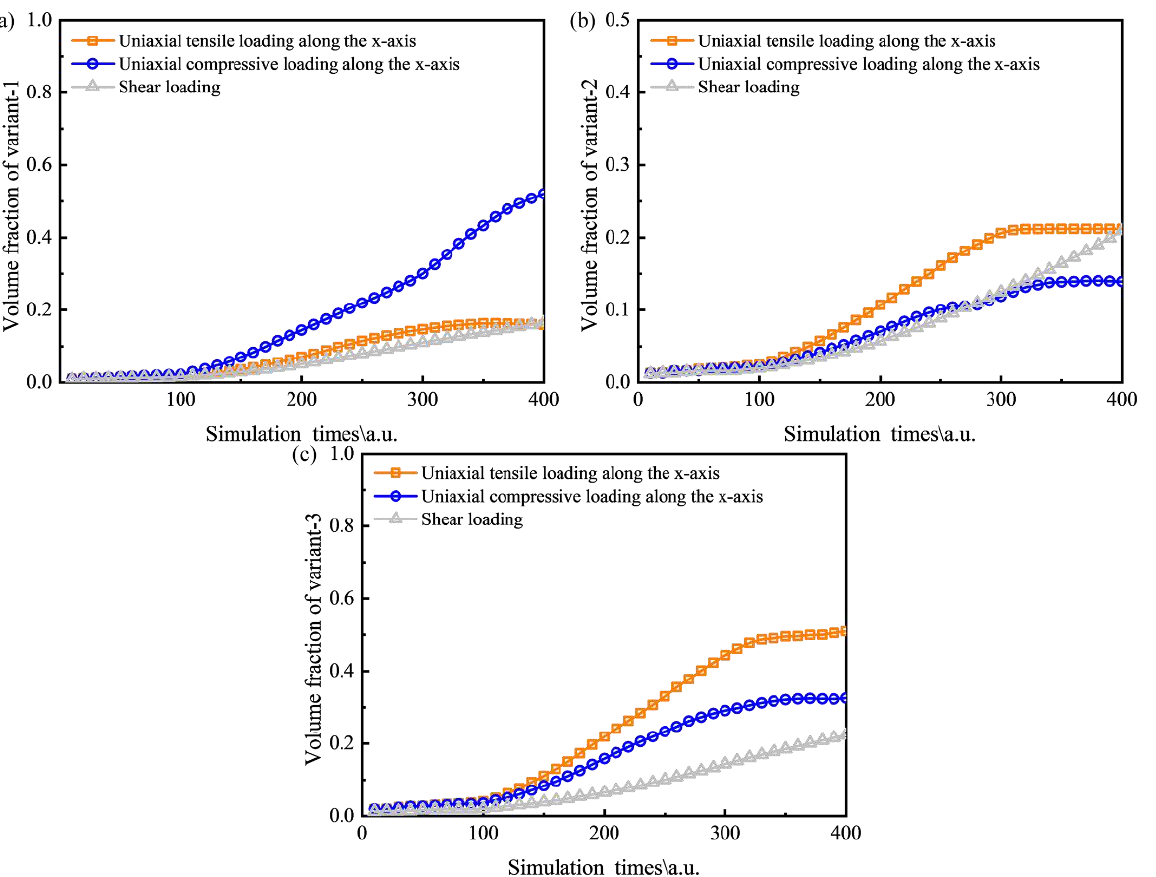
Figure 3. The kinetic curves of the three variants for different loading modes. ( a ) Variant 1, ( b ) variant 2, and ( c ) variant 3.